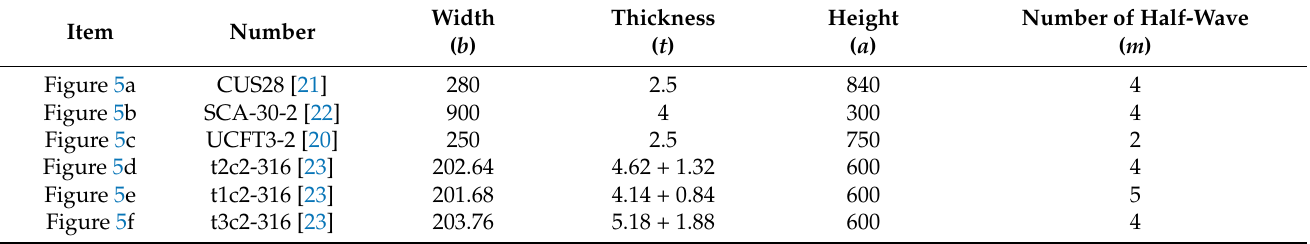
Table 1. Buckling characteristics of the side plate in rectangular CSTC under axial compression in existing studies (unit: mm).